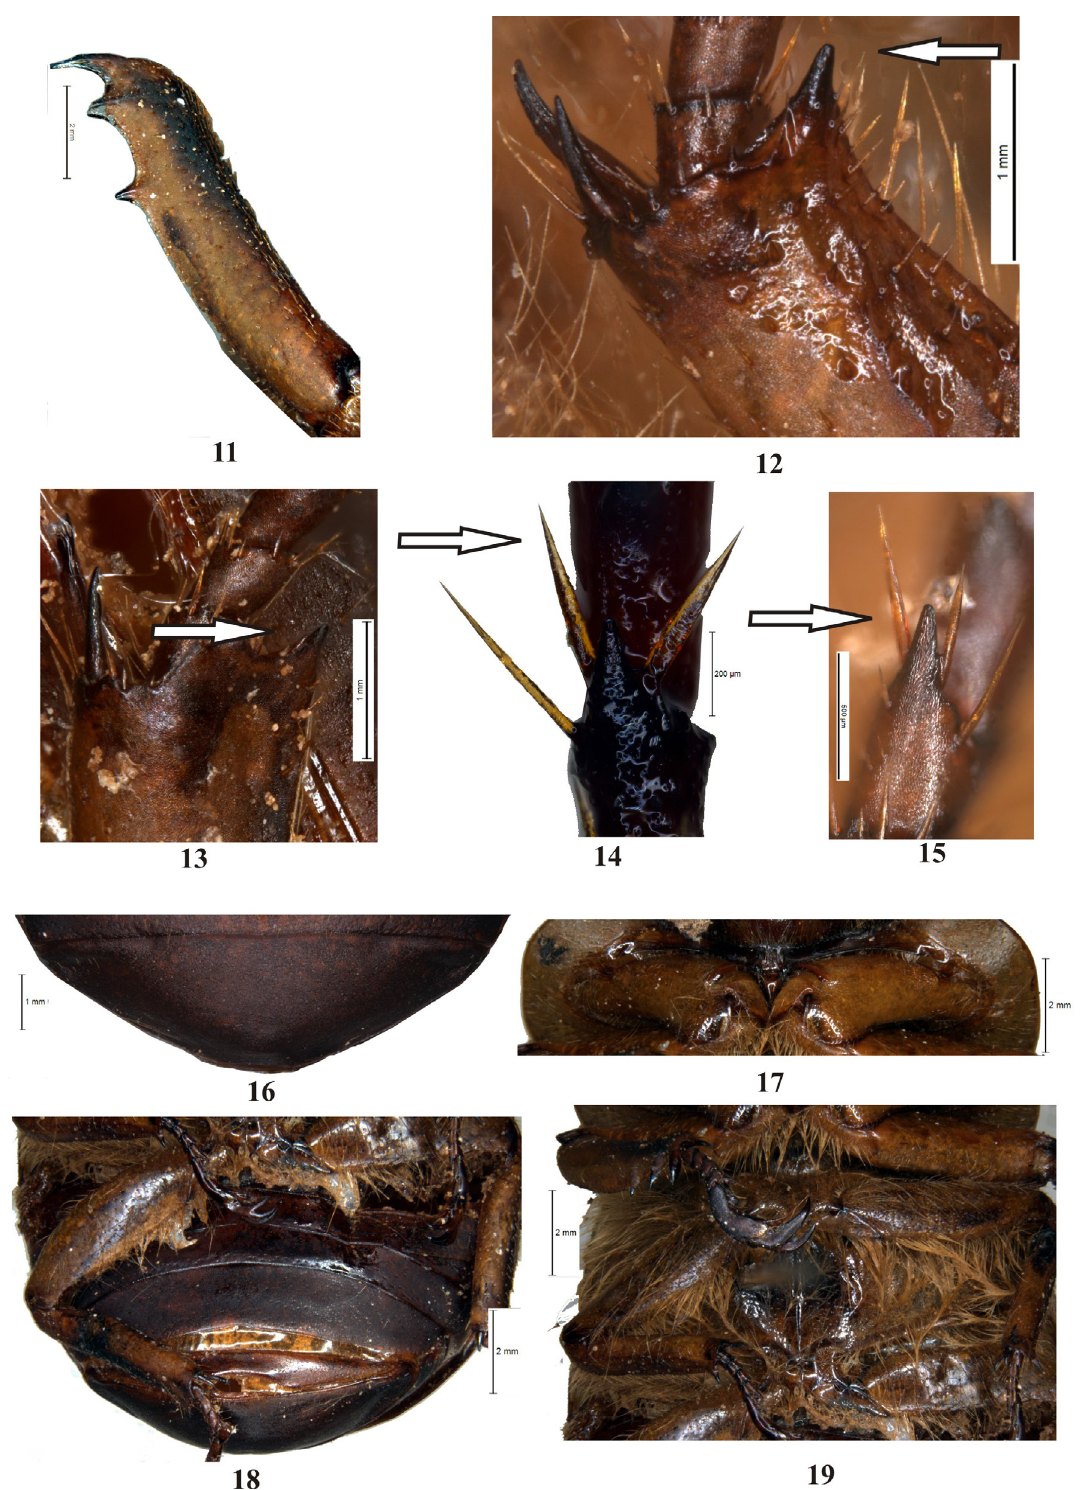
Figs 11–19. Pukupuku arunachalensis sp. nov., holotype, ♂. 11 . Protibia. 12 . Apical part of mesotibia. 13 . Apical part of metatibia. 14 . 4 th mesotarsomere. 15 . 4 th metatarsomere. 16 . Pygidium. 17 . Prosternum. 18 . Abdomen. 19 . Meso- and metasternum. (Arrows indicate the character separating Pukupuku from the closely related